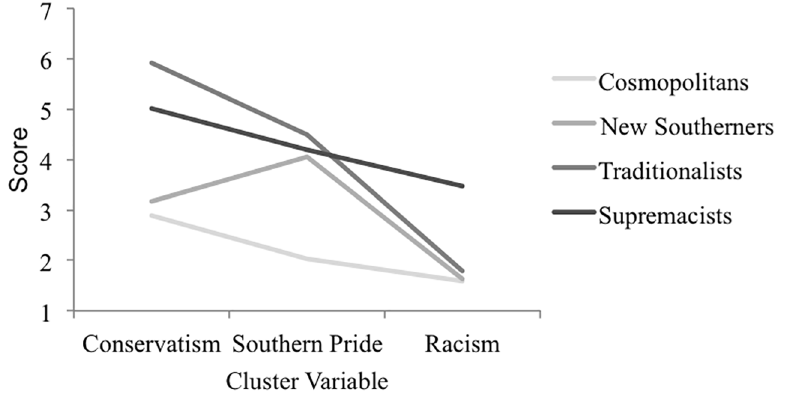
Figure 1. Means for cluster variables by cluster.